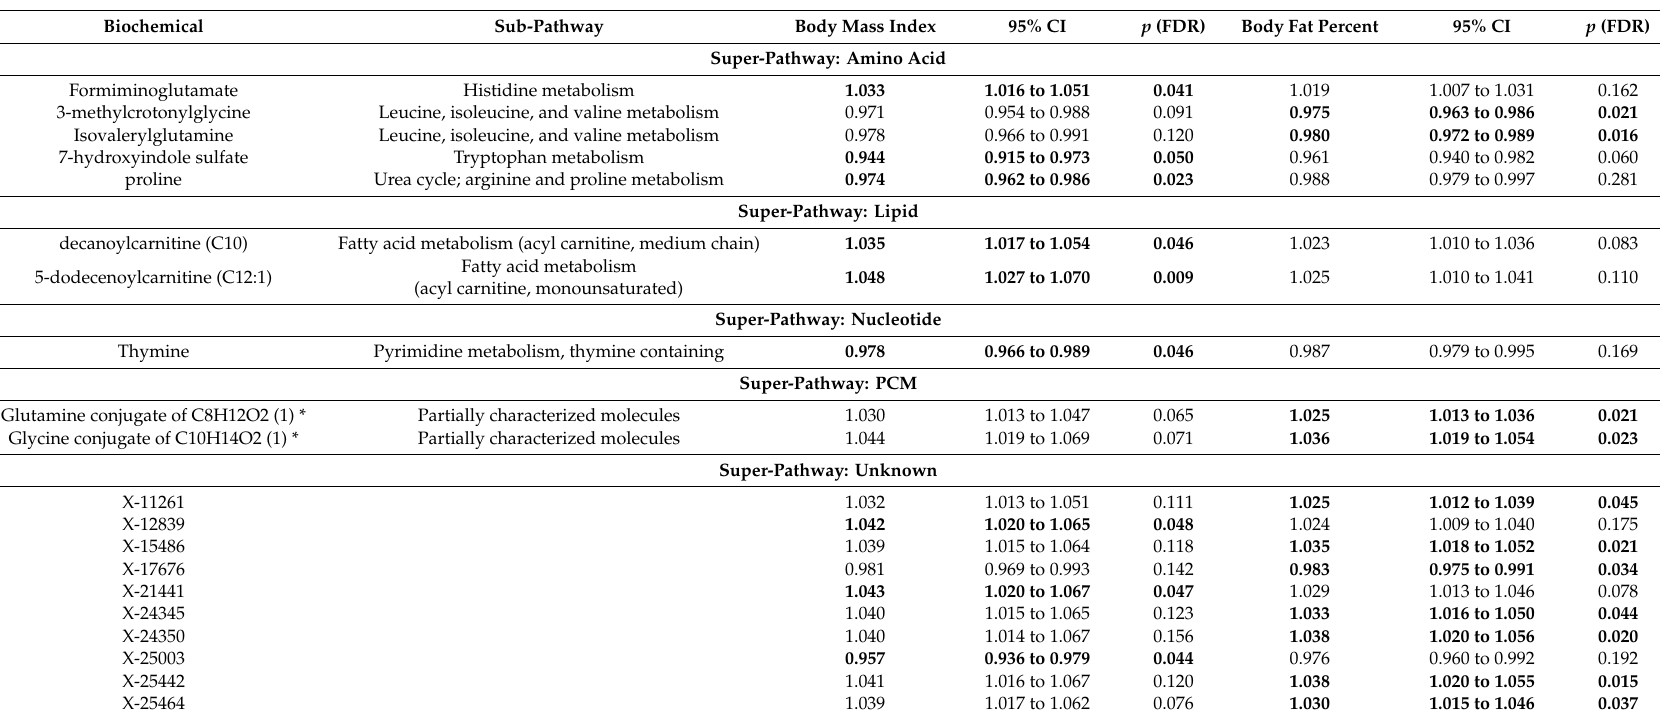
Table A4. Metabolites associated with either BMI or